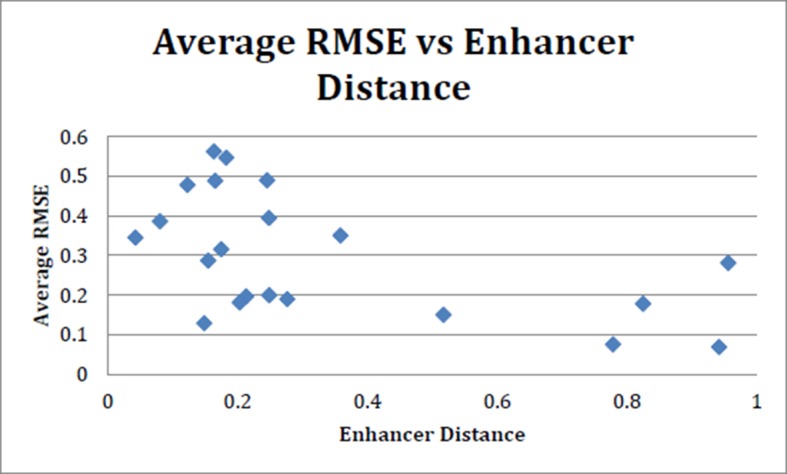
Average RMSE (suite of 24 models) vs enhancer distance as calculated using N2 method.There is no strong trend toward increased performance (lower average RMSE) with more closely related enhancers. N2 method run using code provided in Göke J et al. (Bioinformatics, 2012).